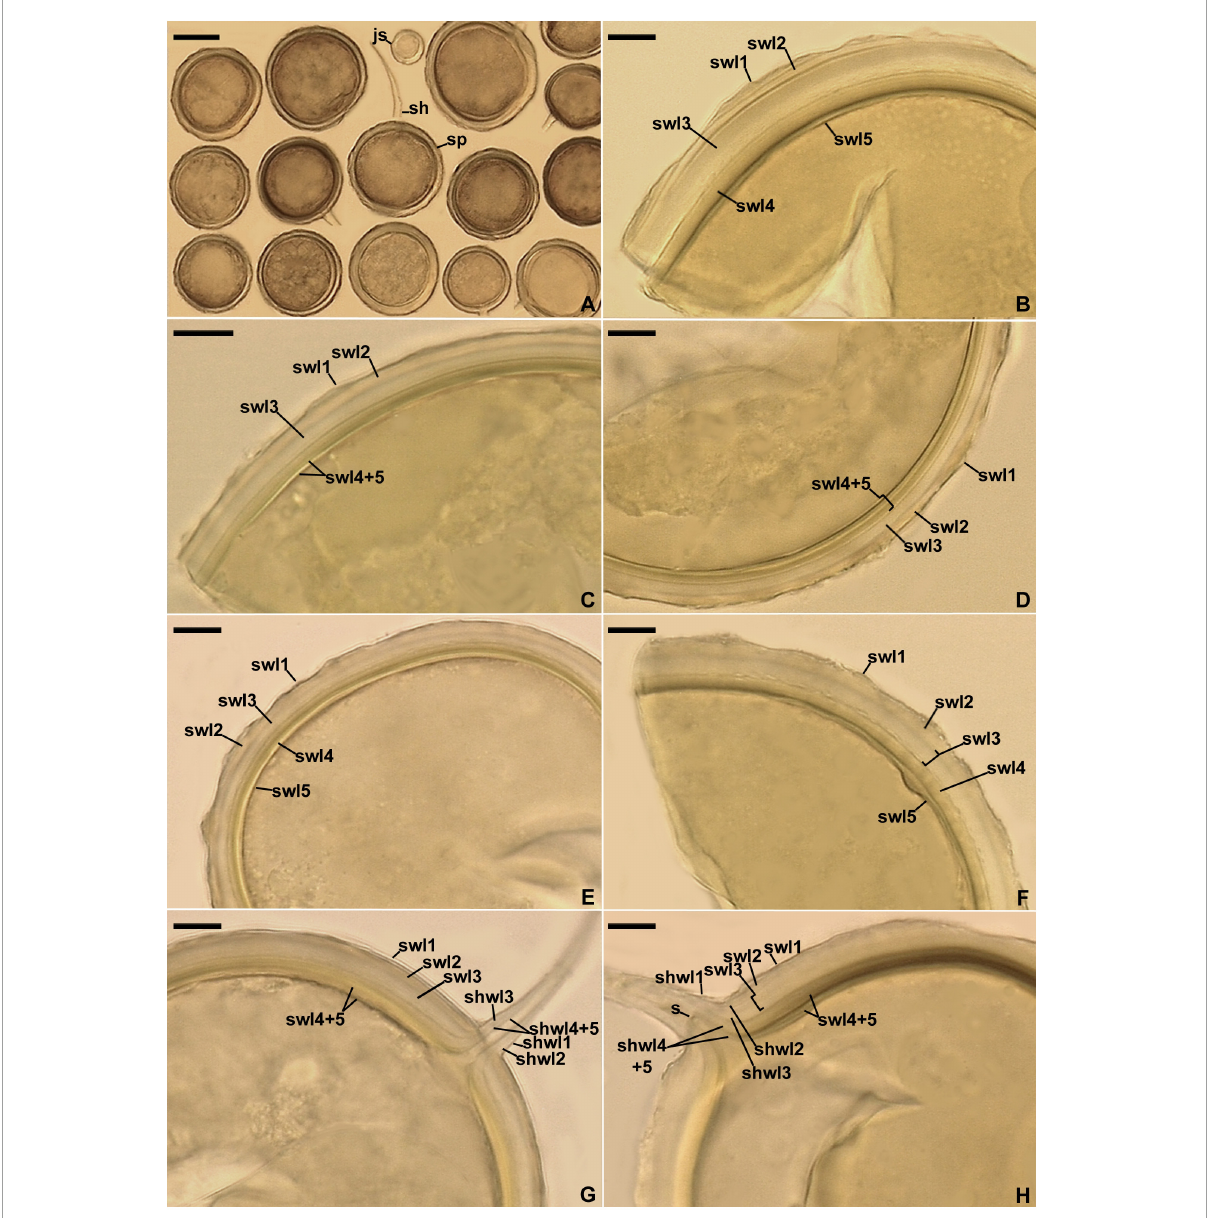
FIGURE8 Entrophospora glacialis . (A) Intact spores (sp) with subtending hyphae (sh); juvenile spore (js) is indicated. (B–F) Spore wall layers (swl) 1–5. (G,H) Subtending hyphal wall layers (shwl) 1–5 continuous with spore wall layers (swl) 1–5; a septum (s) continuous with swl5 is indicated in (H) . (A,E,G,H) Spores in PVLG. (B–D,F) Spores in PVLG+Melzer’s reagent. (A–H) Differential interference microscopy. Scale bars: (A) = 50 µ m, (B–H) = 10 µ m.